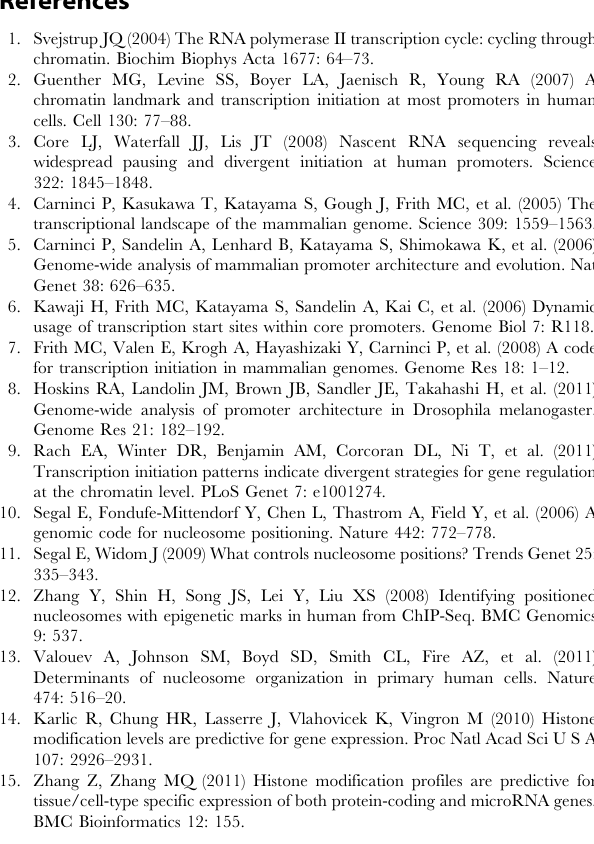
Figure S1 Comparison between TSS entropy’s and STD’s ability to distinguish two Gaussian populations with a uniform noise background. Figure S2 Comparison between TSS entropy’s and STD’s ability to distinguish two Gaussian populations with a Gaussian noise background. Figure S3 Performance distribution of best 2-models for K562 cells. Figure S4 The receiver operating characteristic (ROC) curve for the performance of models trained in GM12878 and applied in NHEK cells. Figure S5 Features selected for the best models.